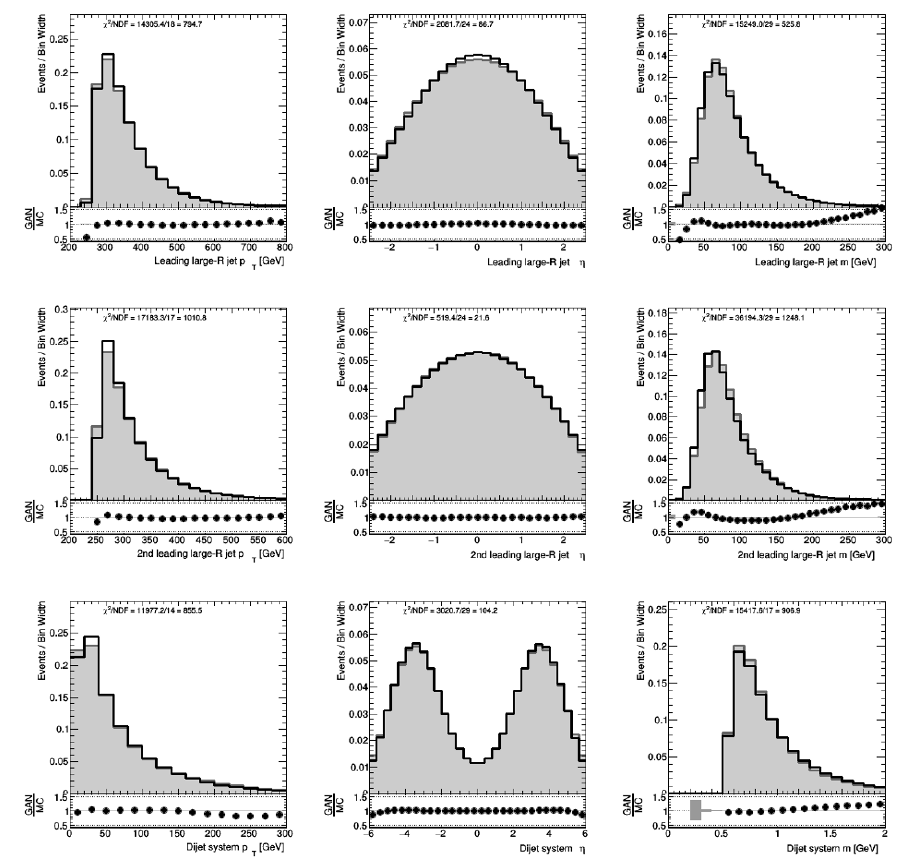
Figure 4 . Comparison of kinematic observables with respect to particle-level ( MadGraph5 + Pythia8 ) Monte Carlo simulation. The gray area represents the MC prediction, and the black line indicates the GAN